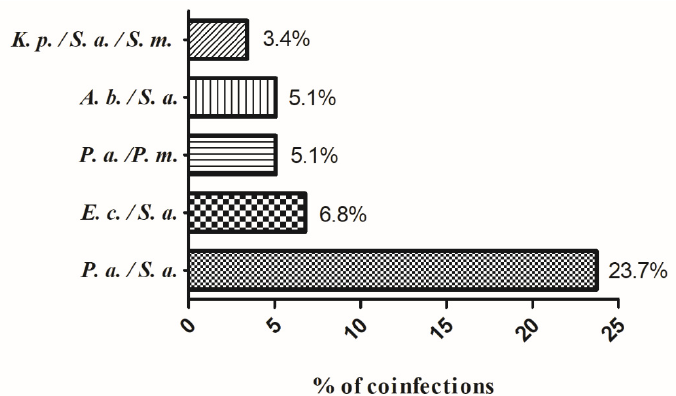
Figure 1. Percentage of co-infections detected in samples with multiple species. The percentage of co-infections was calculated by considering the total number of the co-infections. A. b .: Acinetobacter baumannii/haemolyticus ; E. c .: Escherichia coli ; K. p .: Klebsiella pneumoniae ; P. a .: Pseudomonas aeruginosa ; P. m .: Proteus mirabilis ; S. a .: Staphylococcus aureus ; S. m .: Serratia marcescens.